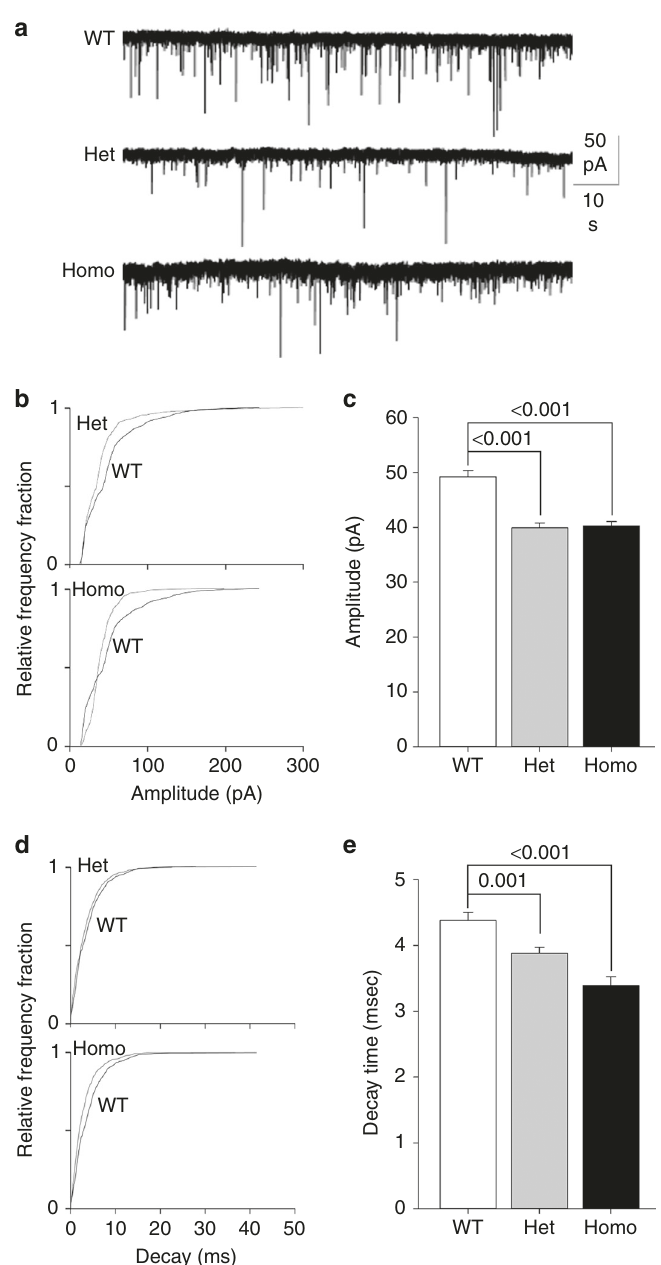
Fig. 5 Gabra2 – 1 mice display alterations in hippocampal phasic current. a Representative recordings made from CA1 in hippocampal slices from p21 Gabra2 – 1 heterozygous and homozygous mice compared to wildtype littermate control mice. Gabra2 – 1 recordings displayed smaller sIPSC amplitudes and decreased decay times compared to wildtype littermate or age-matched controls as seen in the representative traces. Analysis of traces revealed a shift in the cumulative probability plots and bar graphs for sIPSC amplitude ( b , c WT — 49.2 ± 1.16; Het — 39.9 ± 0.91; Homo — 40.3 ± 0.74) and decay ( d , e . WT — 4.38 ± 0.12; Het — 3.88 ± 0.09; Homo — 3.39 ± 0.13). The frequency was comparable between the genotypes, for quanti fi cation see Supplementary Fig. 7. All plots shown and all values listed are mean ± standard error, p values from t test